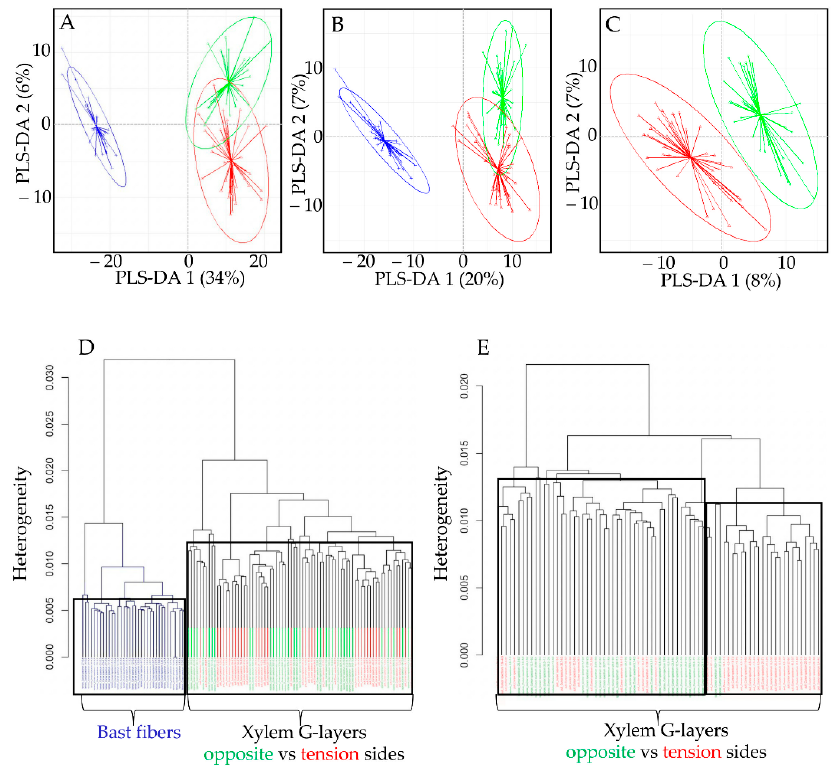
Figure 4. ( A – C ): Partial least squares ‐ discriminant analysis (PLS ‐ DA) biplots Raman spectra. Bast fiber (BF) dataset appears in blue, xylem G ‐ layer datasets from opposite vs. tension sides appear in green and red, respectively. ( D , E ): Hierarchical clustering of Raman spectra from BF (blue) and xylem G ‐ layers (green, red). Dendograms representing the distance (calculated as the spectral contrast angle) amongst the Raman spectra. D, black frames divided BF and xylem G ‐ layers when the dendrogram is cut at k = 0.006 for BF and k = 0.013. E, black frames divided (incompletely) xylem G ‐ layers when the dendrogram is cut at k = 0.013 mainly for opposite G ‐ layer, and k = 0.012 mainly for tension G ‐ layer.